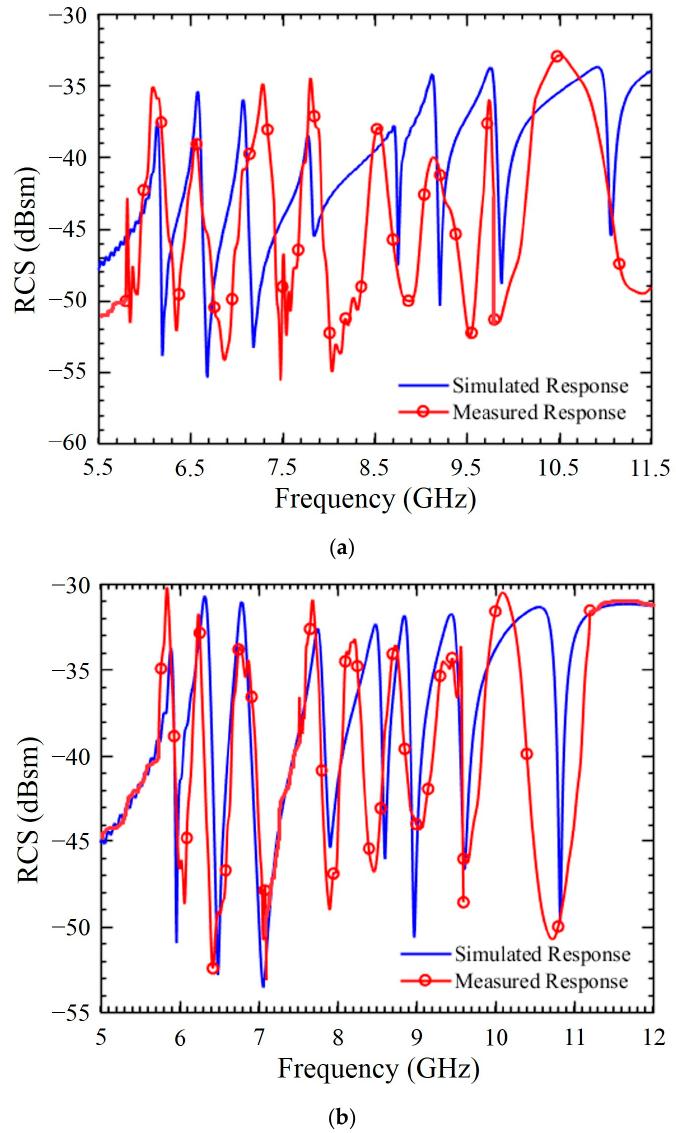
Figure 18. Measured and simulated RCS response of final proposed tag (Configuration-4): ( a ) d = 1 mm; ( b ) d = 0.2 mm.